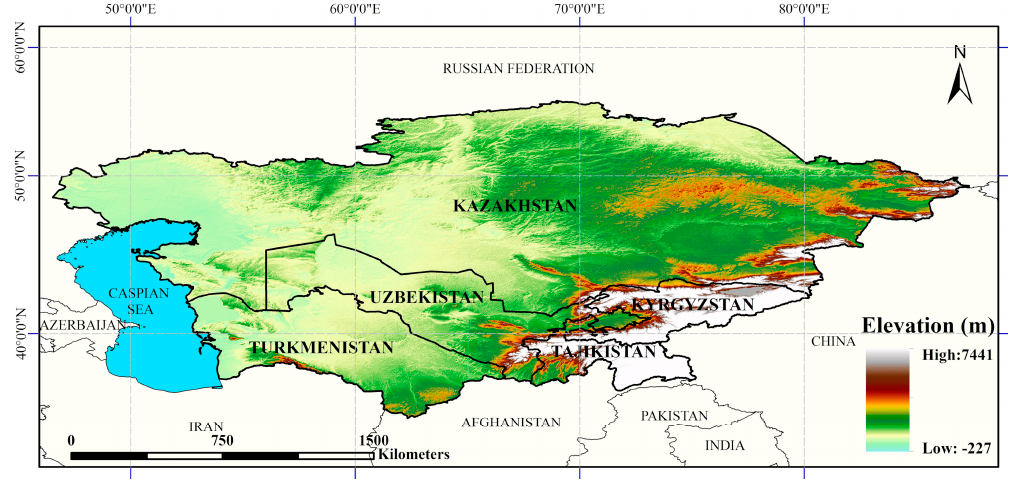
Figure 1. Overview map of the study area. Table 1. Basic information on nine landcover